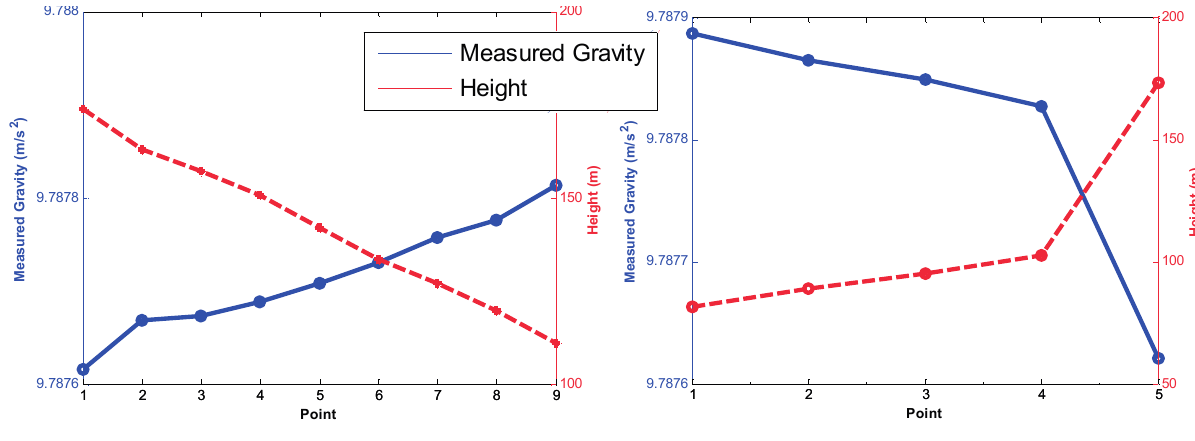
Figure 5. Relationship between the measured gravity and ellipsoidal